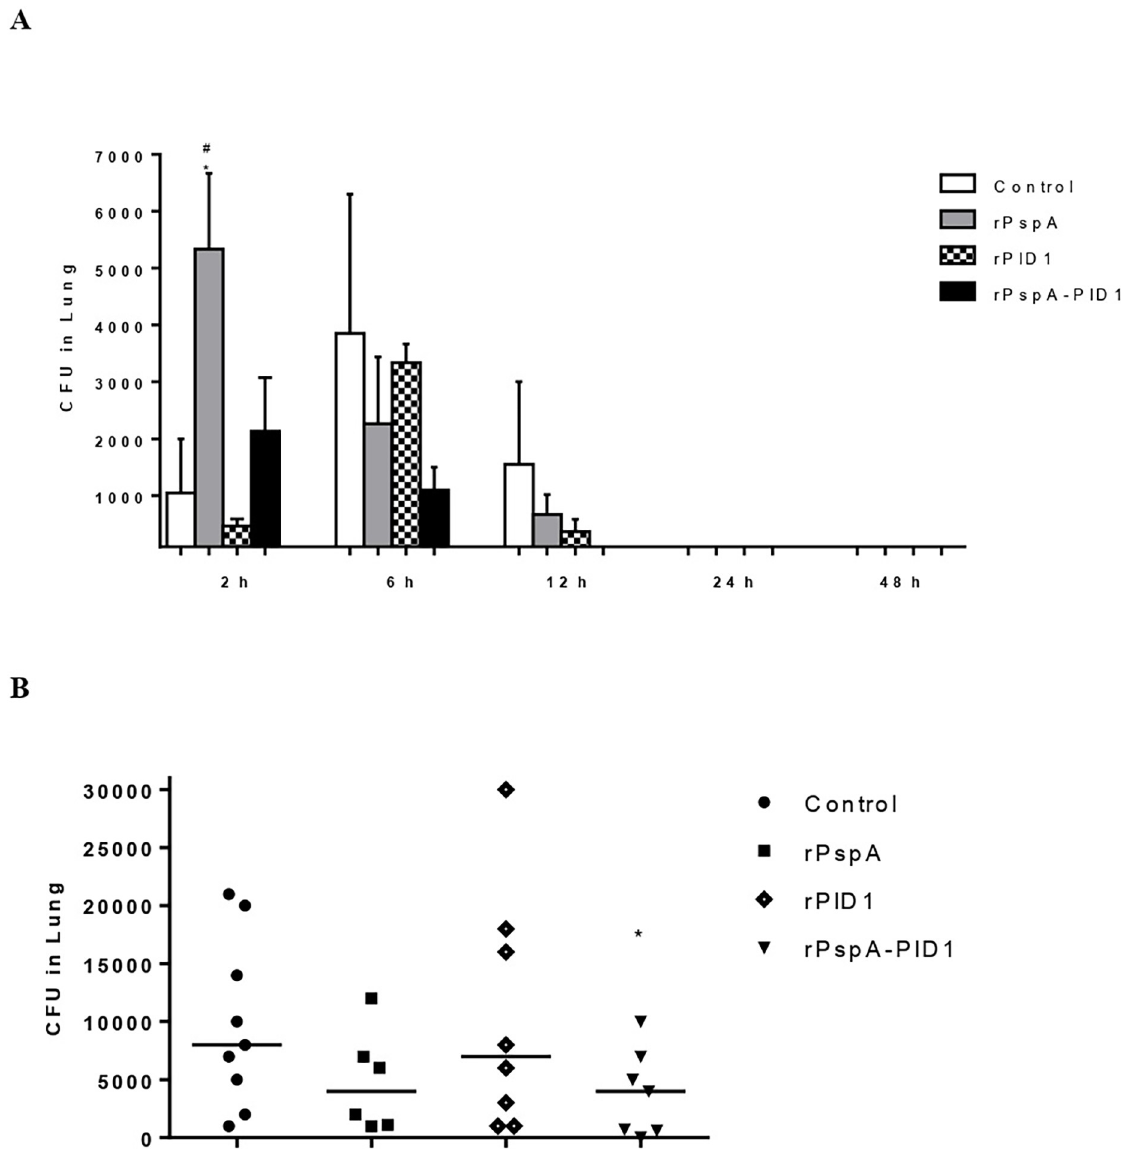
Fig 2. Lung colonization by Streptococcus pneumoniae in mice immunized with rPspA_PlD1. Mice immunized with 3 doses of rPspA, rPlD1, or the fusion protein in Alum were challenged intranasally with 5x10 6 CFU of St 245/00. Bacterial counts in the lungs of immunized and control mice (injected with Alum diluted in PBS) are shown after 2–48 h (A) or seven days (B). ( � p < 0.05 for the same immunization group at different time points and #p < 0.05 for immunized x control